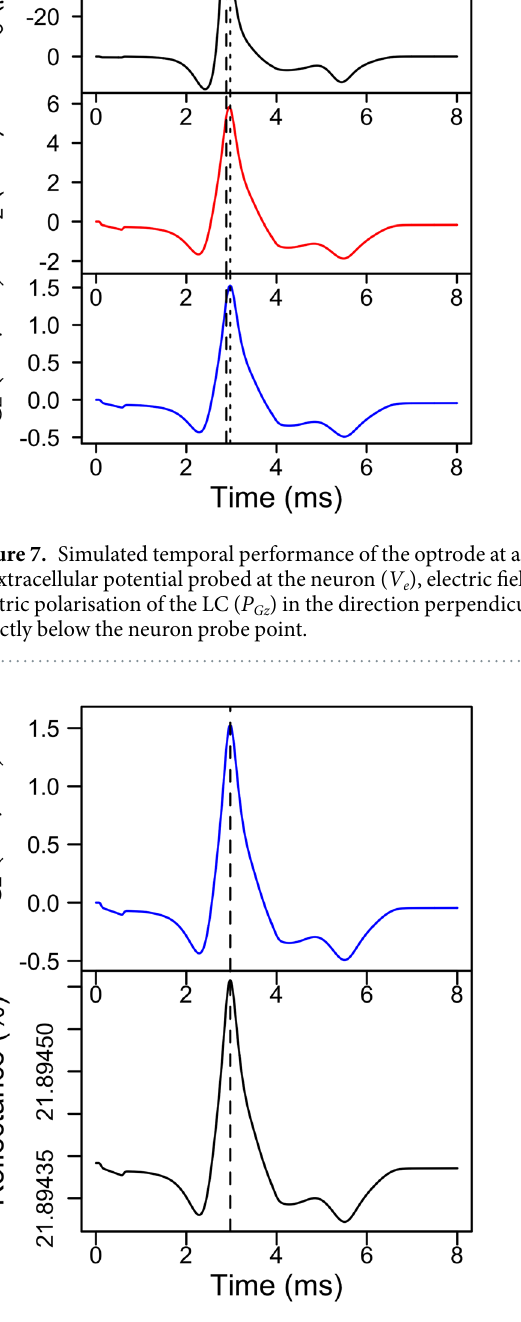
Figure 8. Simulated temporal performance of the optrode at a single channel. Comparison of temporal changes in electric polarisation of the LC ( P Gz ) in the direction perpendicular to the optrode’s circular surface, and reflectance R under parallel polariser/analyser. P Gz was measured directly below the neuron probe